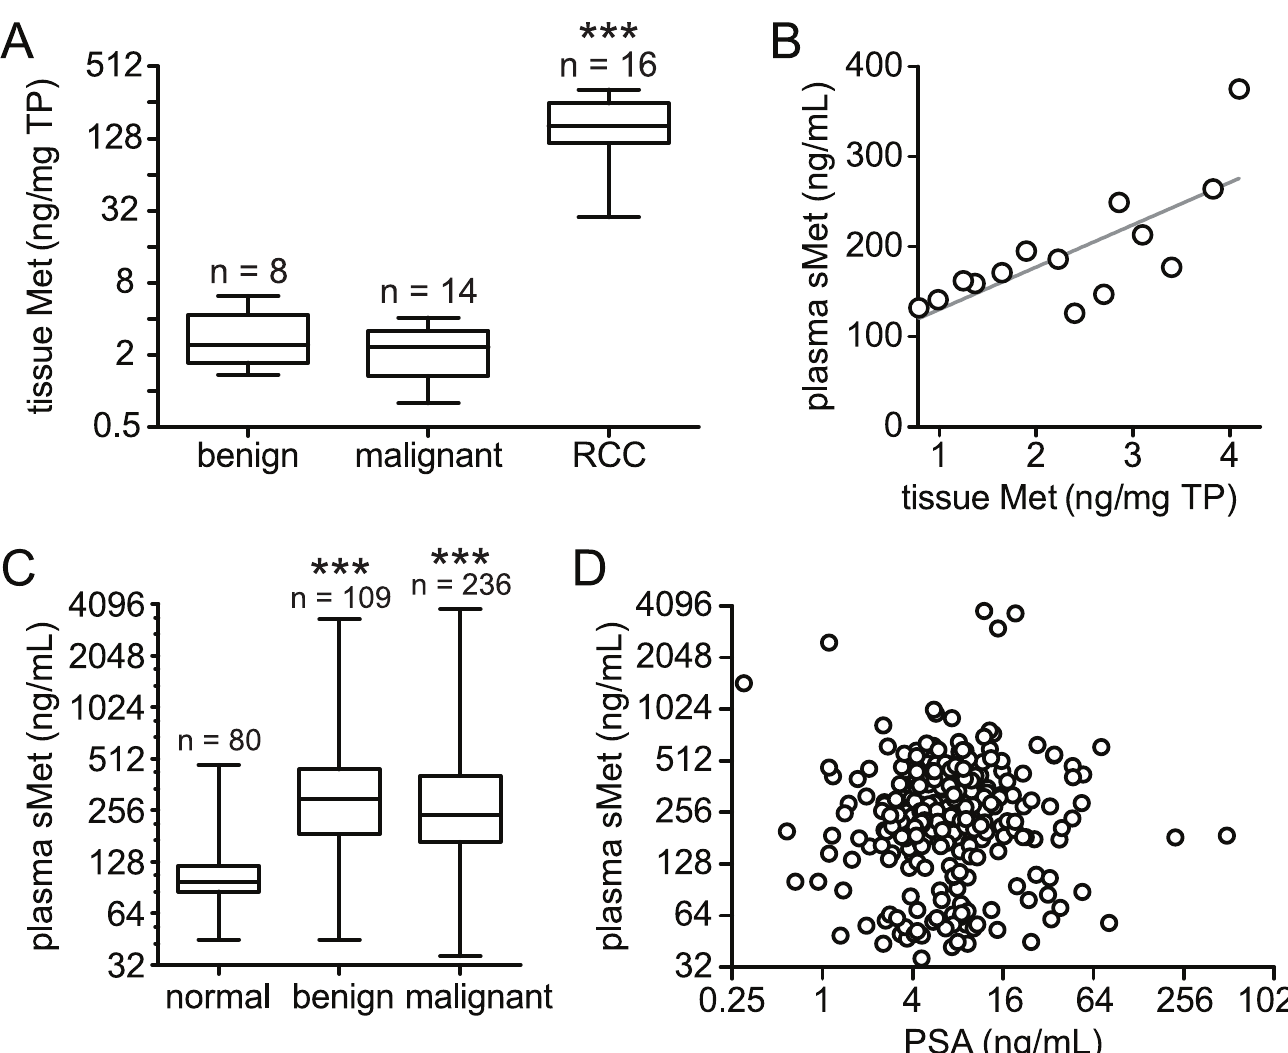
Fig 1. A. Box and whisker plots of tissue Met content (ng Met/mg total protein) in primary prostate adenocarcinoma biopsies obtained using ultrasound/ MRI fusion image guidance for benign (n = 8) and malignant (n = 14) groups, selected on the basis of total protein content needed for repeated analysis; median values were not significantly different (Mann-Whitney p = 0.4927). The median Met content of a group of renal cell carcinoma (RCC; n = 16) samples of various histologies was significantly higher than either the benign or malignant PCa groups ( *** , Mann-Whitney p < 0.0001). B. Plasma sMet concentrations (ng/ml) and tissue Met content for patients in the malignant PCa group were significantly correlated (Wilcoxon Matched-pairs Two-tailed Signed Rank Test p = 0.0001; Spearman r = 0.7143, p = 0.0027). C. Box and whisker plots of plasma sMet (ng/ml) show the median value for a group of healthy male volunteers with no known cancer (normal, n = 80) is significantly lower than either benign (n = 109) or malignant (n = 236) groups ( *** Spearman r = 0.2939, p < 0.0001). D. Matched plasma sMet (ng/ml) vs PSA (ng/ml) values for 274 patients for whom samples for both tests were drawn at the same time show no significant correlation (Spearman r = 0.05492, p =